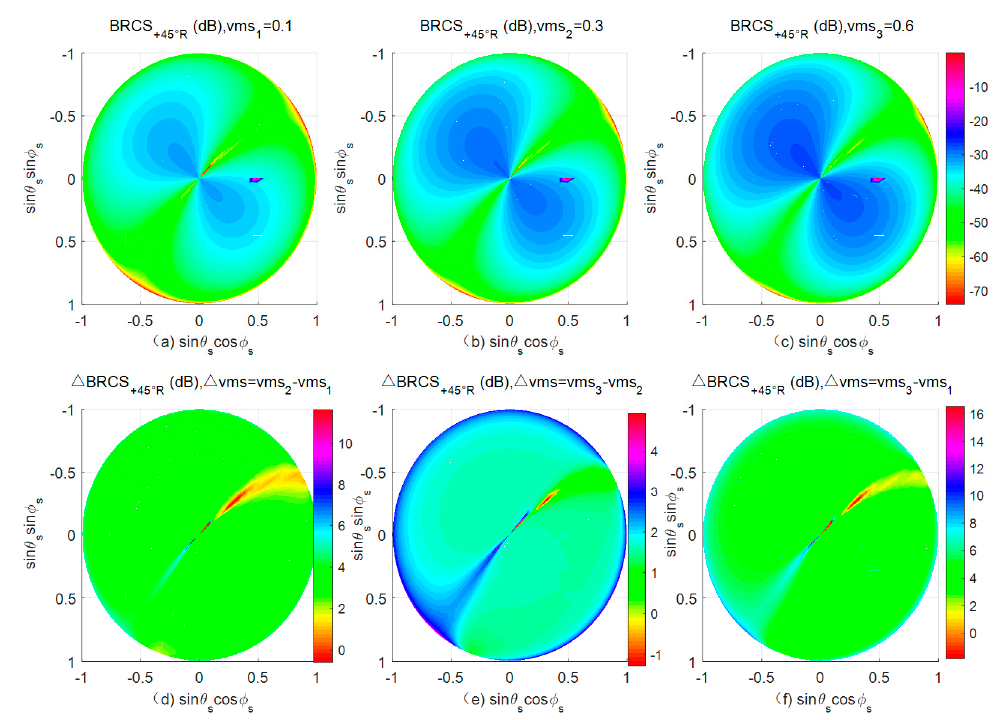
Figure 11. BRCS for different soil moisture contents ( a – c ) and the BRCS differences for different soil moisture differences ( d – f ) at +45° R polarization.